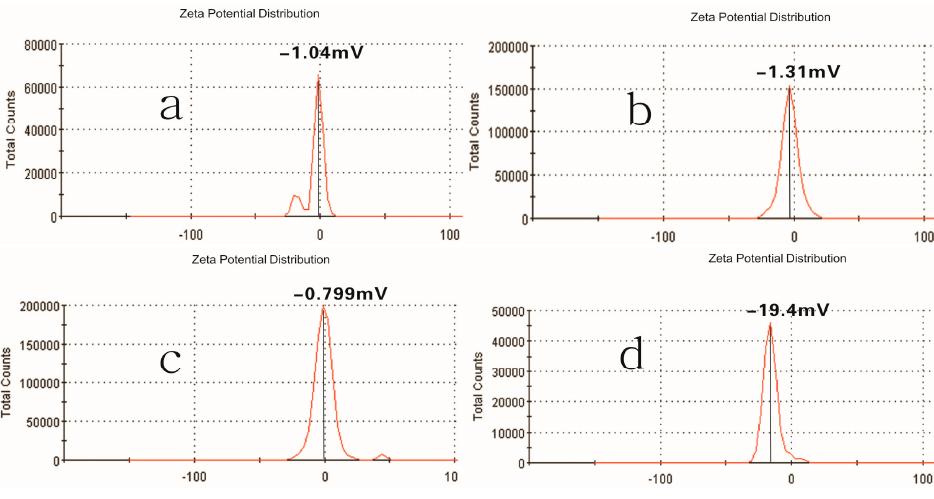
Figure 7. Zeta potential of CHP − 6.91 ( a ), CHP − 6.03 ( b ), CHP − 3.11 ( c ) and CHCP ( d ) nanoparticles.